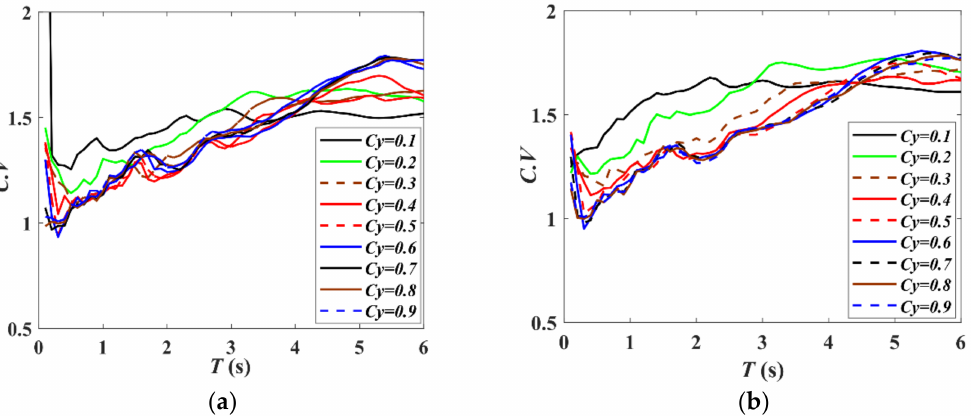
Figure 4. Analysis of the effect of different yield strength coefficients on the discreteness of the S d spectrum. ( a ) Bilinear model, ( b ) odified Clough